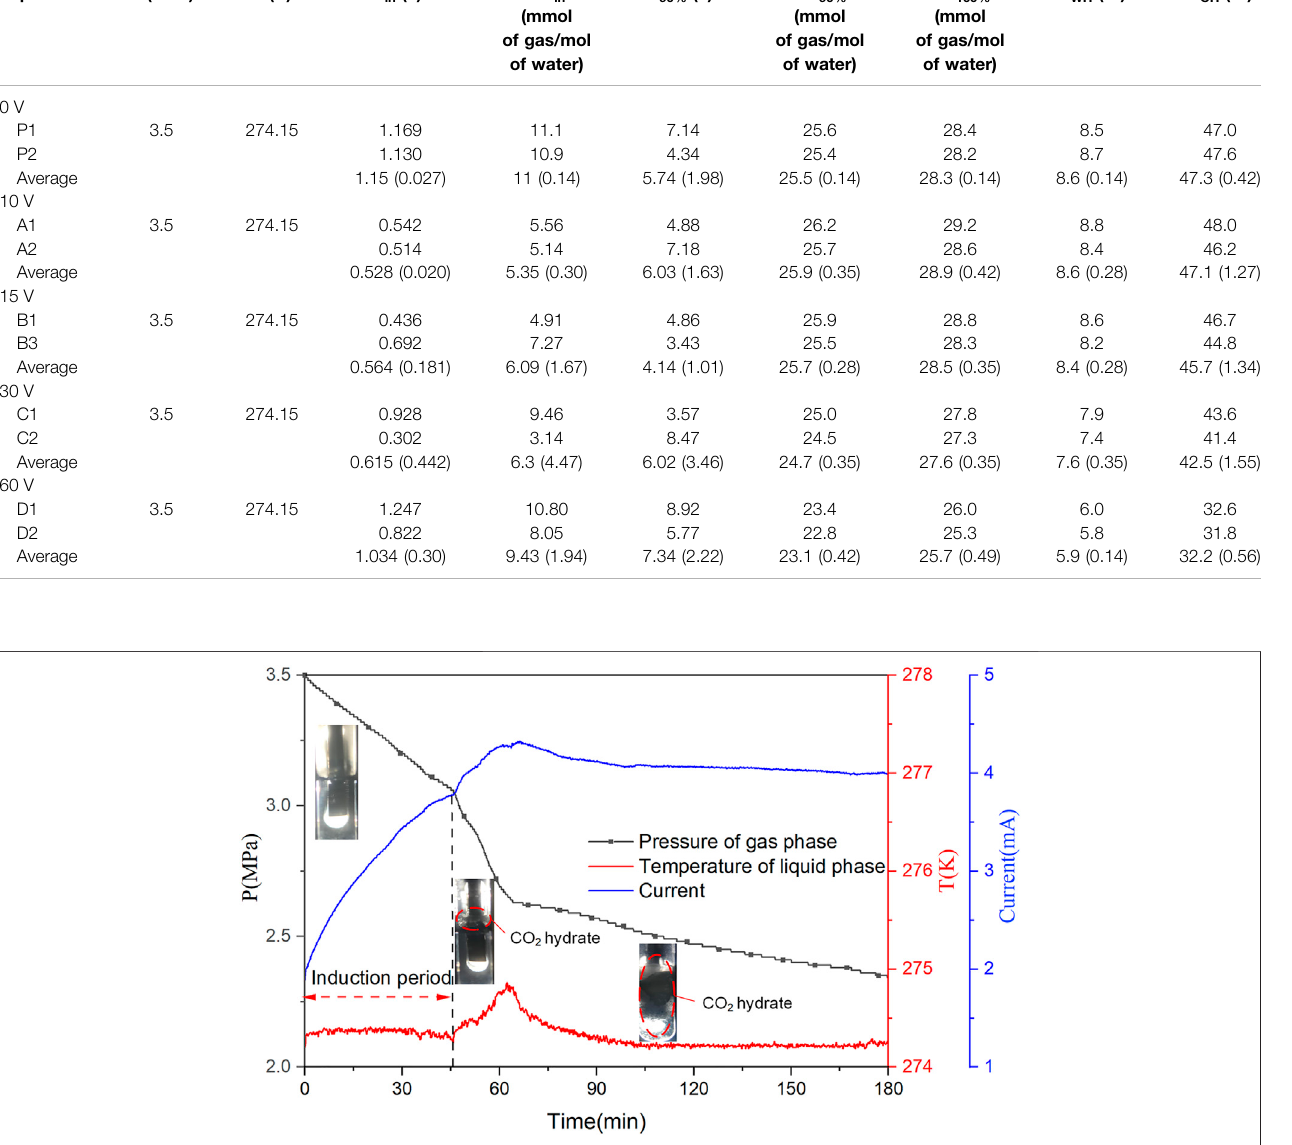
Frontiers in Energy Research |